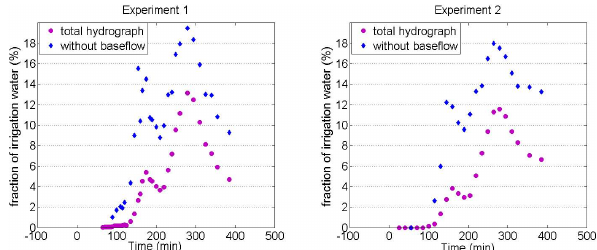
Fig. 5. Bromide based hydrograph separation of the first (left) and second (right) experiment. Shown is the proportion of irrigation wa- ter at the tile- drain discharge in the total measured discharge, and with baseflow subtracted.